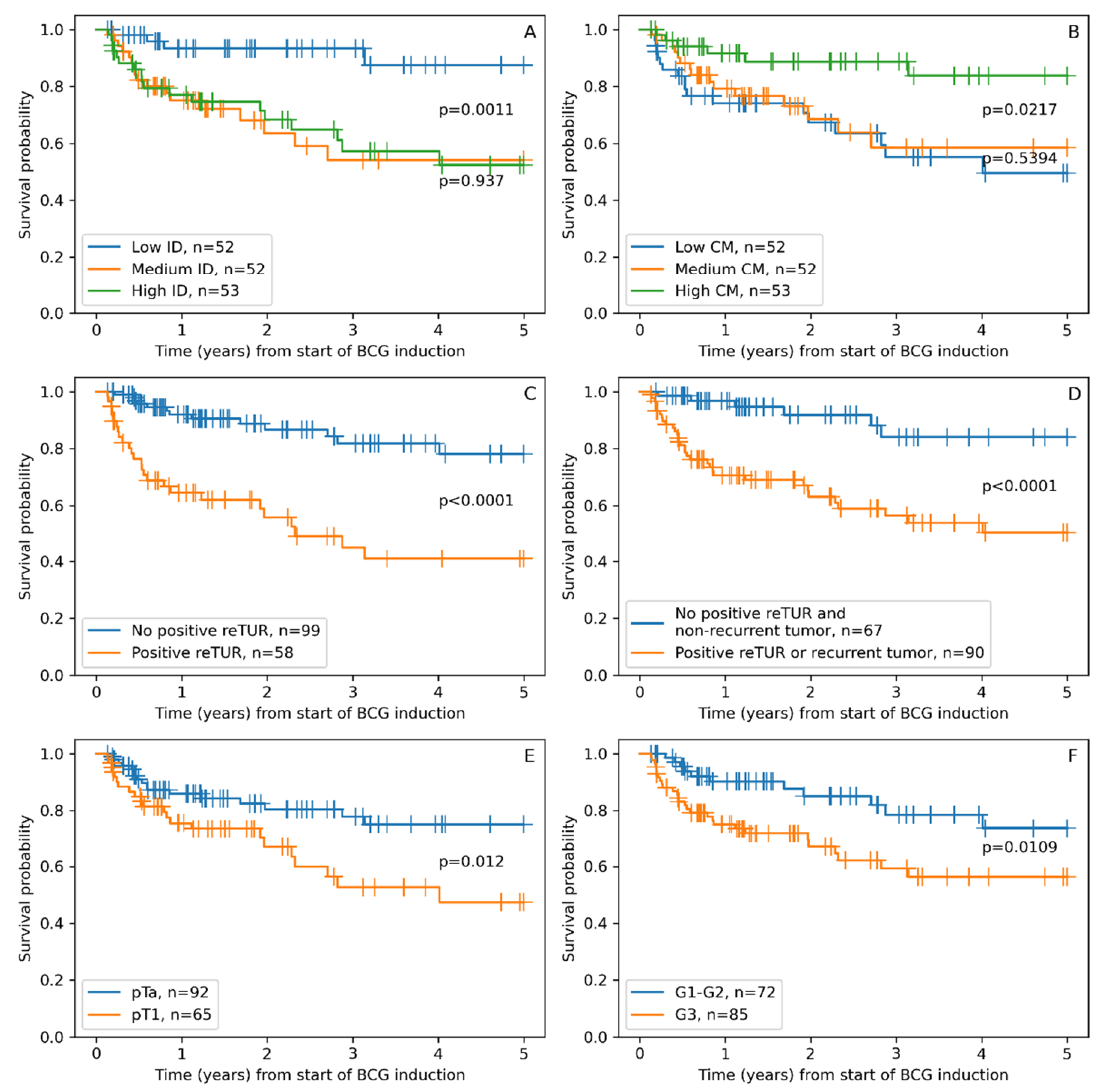
Figure 2. Kaplan–Maier RFS plots stratified according to: ( A ). Immunodrop (ID), ( B ). Center of mass (CM), ( C ). Presence of tumor in reTUR, ( D ). Presence of tumor in repeated transurethral resection (reTUR) or recurrent tumor, ( E ). Tumor stage (pTa vs. pT1), ( F ). Tumor grade (G3 vs. G1–G2).